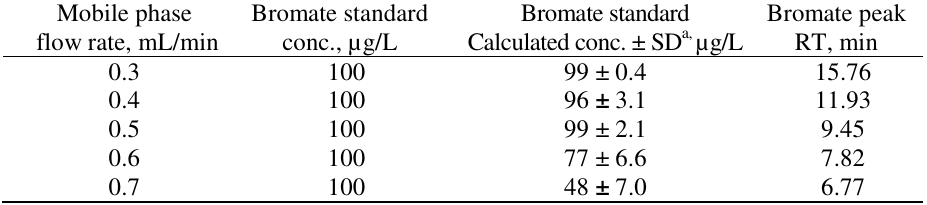
Figure 1. Plot of bromate standard calculated concentration against the eluent flow rate chromatographic conditions are listed under experimental conditions Table 3. Effect of the mobile phase flow rate on bromate standard concentration and retention time (RT)